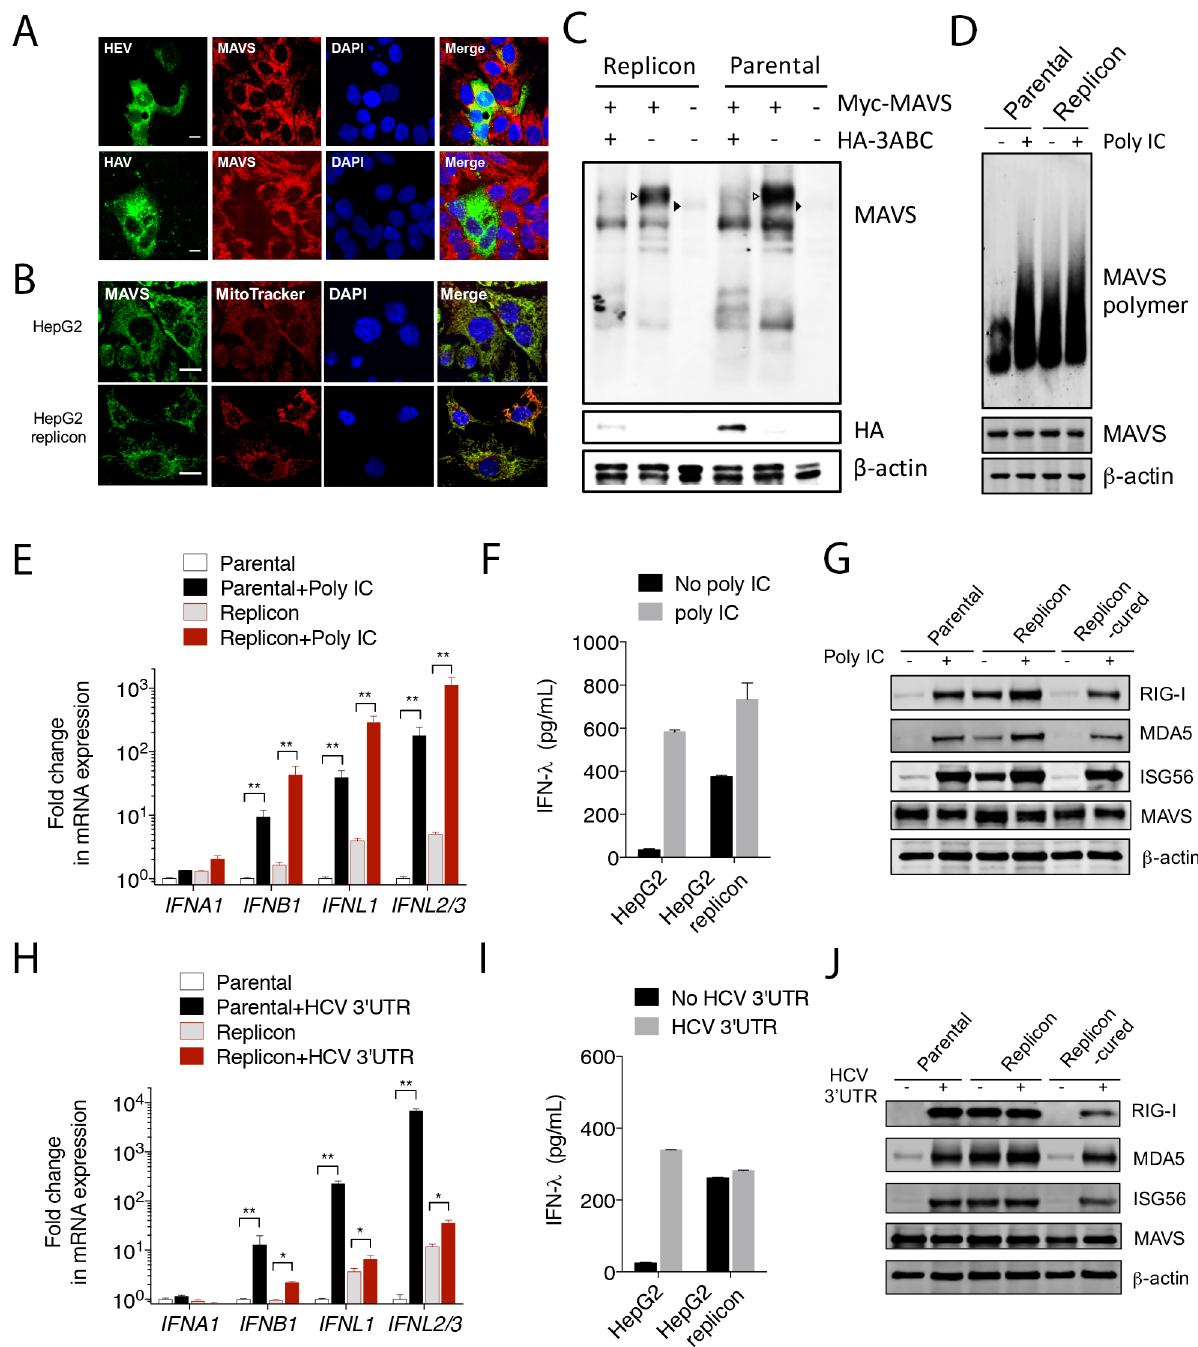
Fig 4. HEV does not target MAVS. (A) ConfocalimagesshowingMAVS and viral antigensin HepG2 cells infected with either HEV (top) or HAV (bottom). Cells werestained 5 days after infectionwith a rabbitanti-MAVS, chimpanzee 1313serum (HEV), or a murinemonoclonal antibody K24F2 (HAV). DAPI was usedto stain the nuclei. Scale bar: 10 μ m. (B) Confocalimagesshowingthe mitochondriallocalizationof MAVS in HepG2 cells with or withoutHEV replicon.MAVS was stainedwith a rabbit antibodyagainstMAVS (green). Mitochondria was visualized with MitoTracker (red). Nucleiwere stainedwith DAPI. Scale bar: 10 μ m. (C) HepG2 cells with or withoutthe HEV replicon were transfected with a MAVS-expressing plasmidalongwith a HAV 3ABC-expressingplasmidor an empty vector. The endogenous(closed arrowheads) and overexpressed MAVS (open arrowheads) were detected with a rabbit anti-MAVS antibody. Note that co-expressionof HAV 3ABC led to the degradation of MAVS. ( D )HepG2 cells with or withoutthe HEV repliconweretransfectedwith poly IC (6 μ g/ml). After 6 h, cells were lysedand subjected to Western blot analysis usingantibodies against MAVS and β -actin.Crudemitochondria were isolated